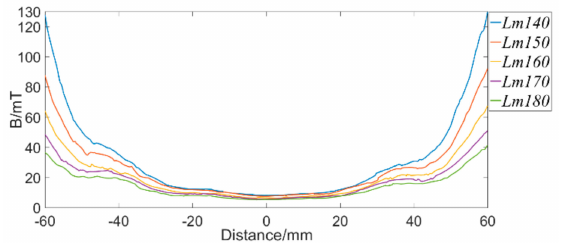
Figure 7. Magnetic flux density at intermediate positions of exciter with di ff erent L m